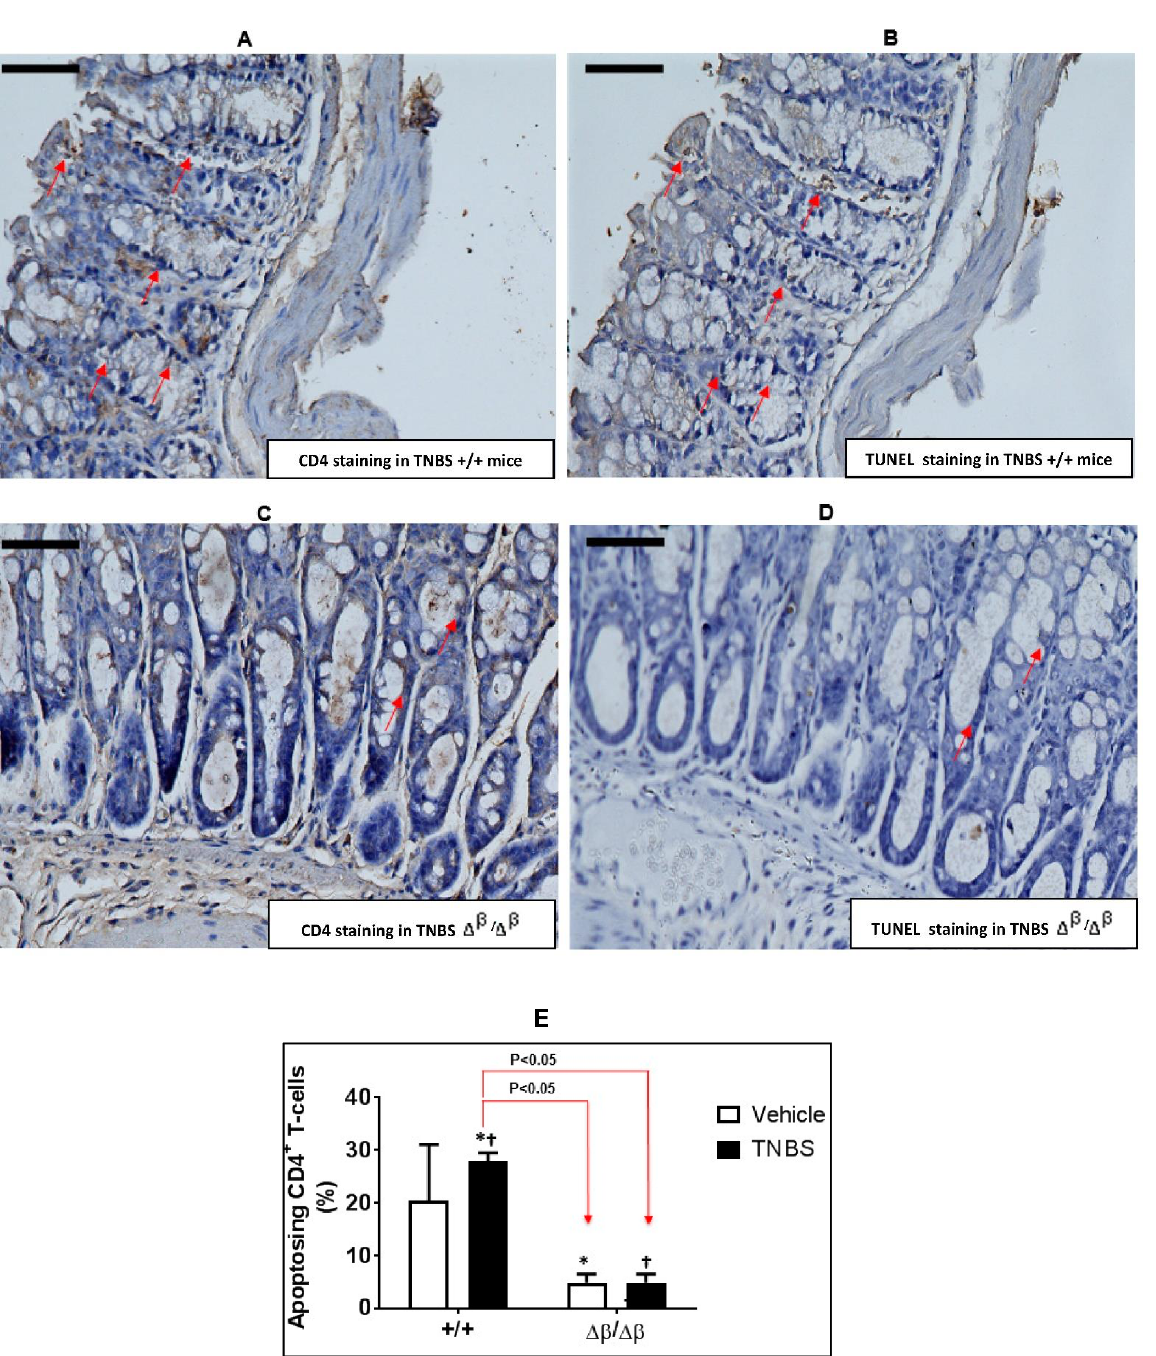
Figure 2. Effect of TNBS-induced CD on apoptosis of CD4 + cells in colons of +/+ and ∆ β / ∆ β mice. Representative photomicrographs of CD4-stained and TUNEL-stained sections of colons (magnification 400 × ) derived from; ( A , B ) TNBS +/+ mice and ( C , D ) TNBS ∆ β / ∆ β mice. Red arrows depict cells positively stained for CD4 or TUNEL. Scale bar on each micrograph represents 50 microns. CD4 + cells (500–1000 per section) within colon sections IHC stained for CD4 were assessed on the adjacent slide for TUNEL positivity or negativity. ( E ) The percentage TUNEL-positive cells expressed as mean ± SD ((*, TNBS (+/+ mice) vs. vehicle ( ∆ β / ∆ β mice), † , TNBS (+/+ mice) vs. TNBS ( ∆ β / ∆ β mice), both p < 0.05, ANOVA followed by Tukey’s post-test; n =